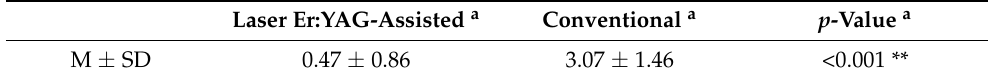
Table 1. The results of the statistical analysis of the Wong–Baker pain scores. Laser Er:YAG-Assisted a Conventional a